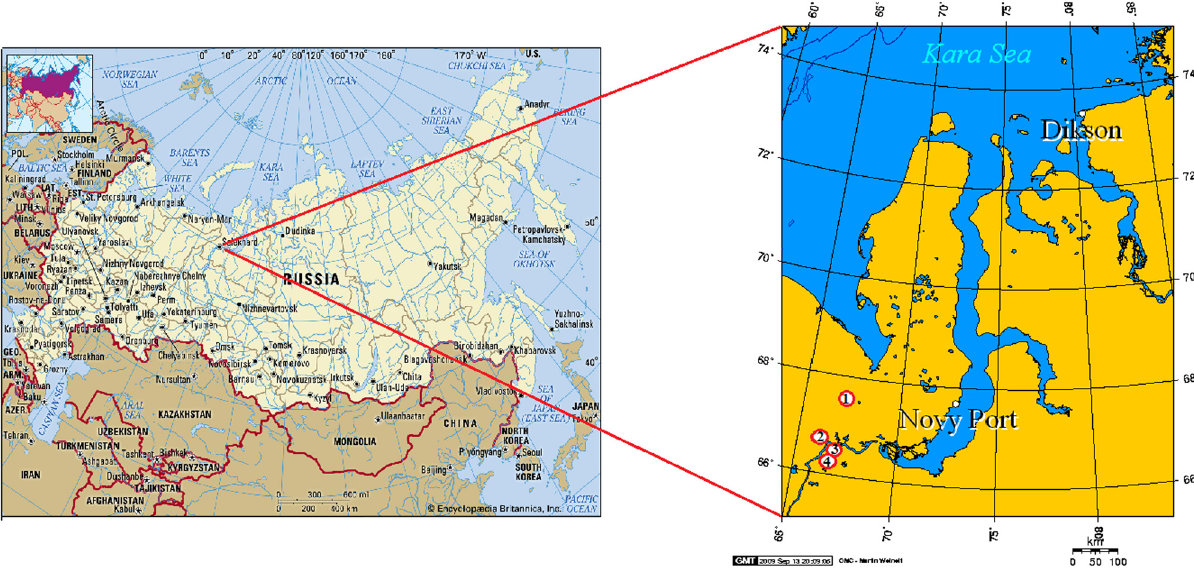
Figure 1: The map of the study area. Sites: 1 – Mature tundra, 2 – recreational functional zone ( former crop fi eld ) ; 3 – recreational functional zone ( former vegetable garden ) ; 4 – recreational functional zone ( urbanized ecosystem )